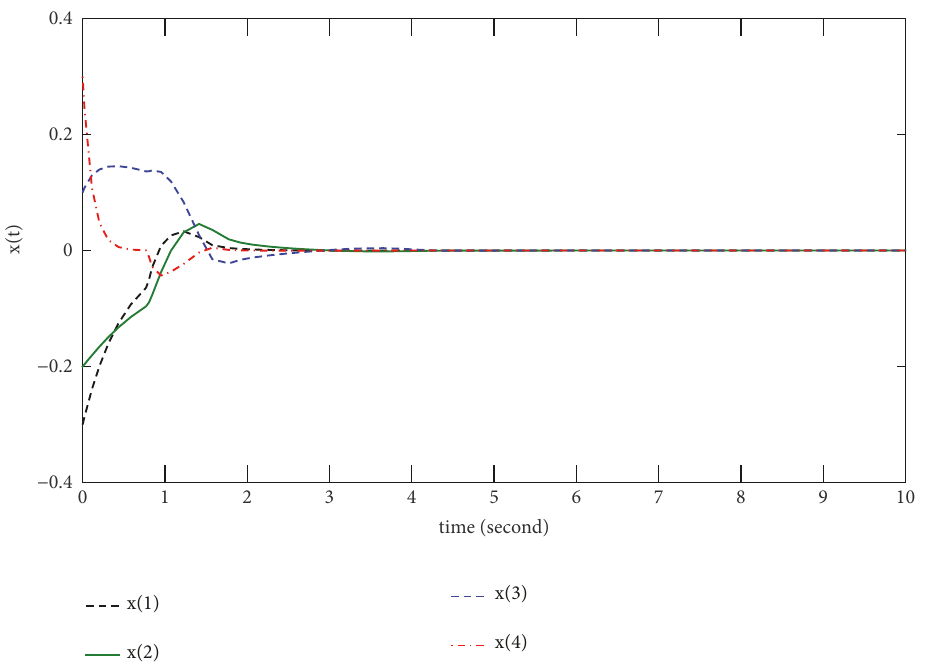
Figure 5: State response of the event-trigger nonlinear networked control